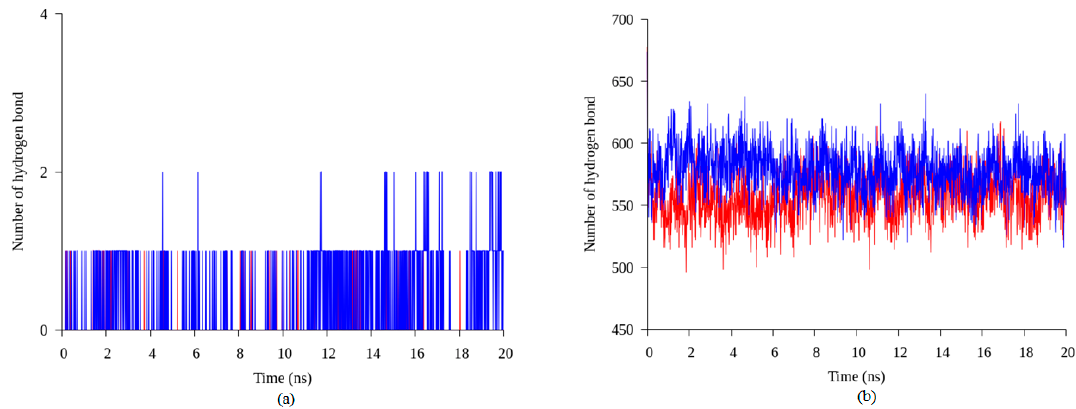
Figure 6. Hydrogen bond interaction in the earth-grown and space-grown T1 lipase structures: ( a ) Hydrogen bond numbers between amino acid Thr306 and Asn304 in the space-grown (blue) and earth-grown (red) structures during 20 ns of simulation; ( b ) Number of hydrogen bonds in the space-grown (blue) and earth-grown (red) structures during 20 ns of simulation.